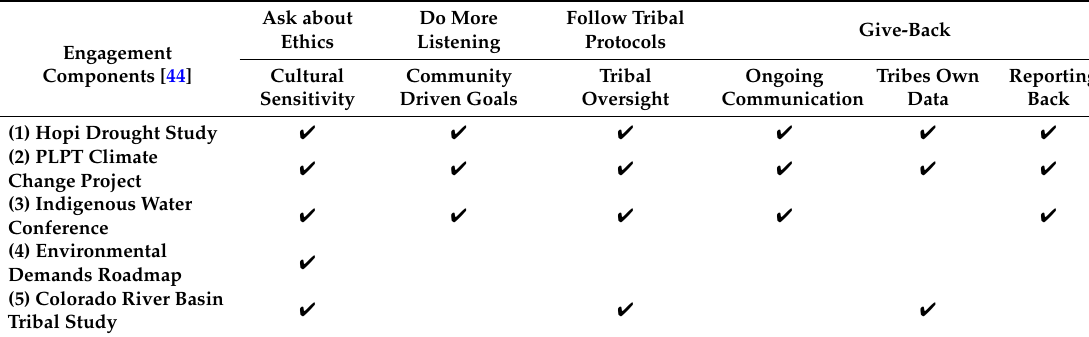
Table 3. Components to gain trust and build partnerships with tribes by case study